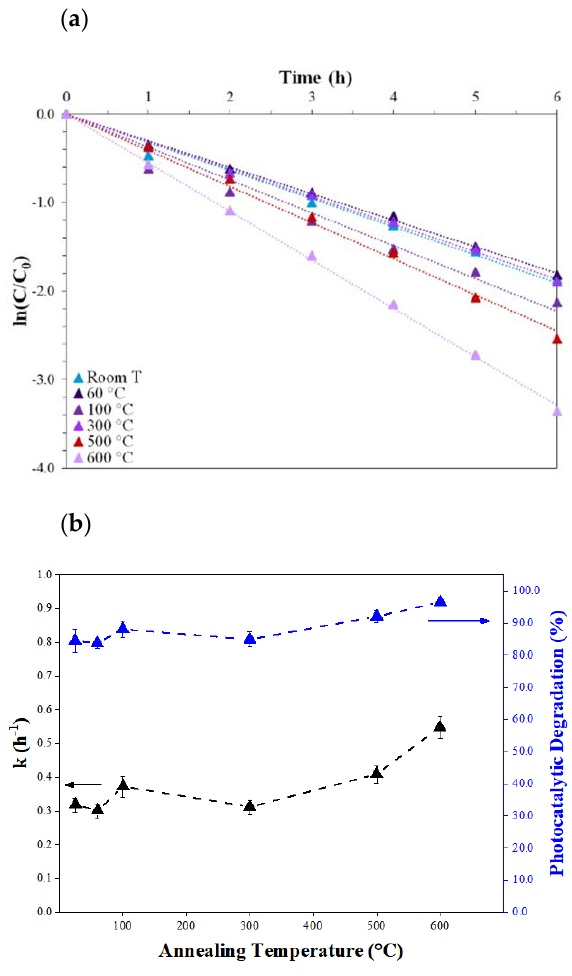
Figure 6. ( a ) Kinetics of RhB photocatalytic degradation for different annealing temperatures. ( b ) Effect of annealing temperature on photocatalysis kinetics and degradation percentage.